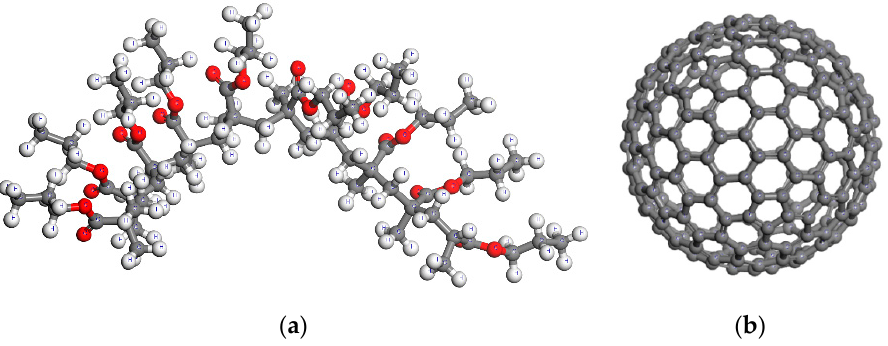
Figure 2. Molecular structure of the: ( a ) poly(methyl methacrylate) (PMMA) chain and ( b ) C 240 Figure2. Molecularstructureofthe: ( a )poly(methylmethacrylate)(PMMA)chainand( b )C 240 fullerene.